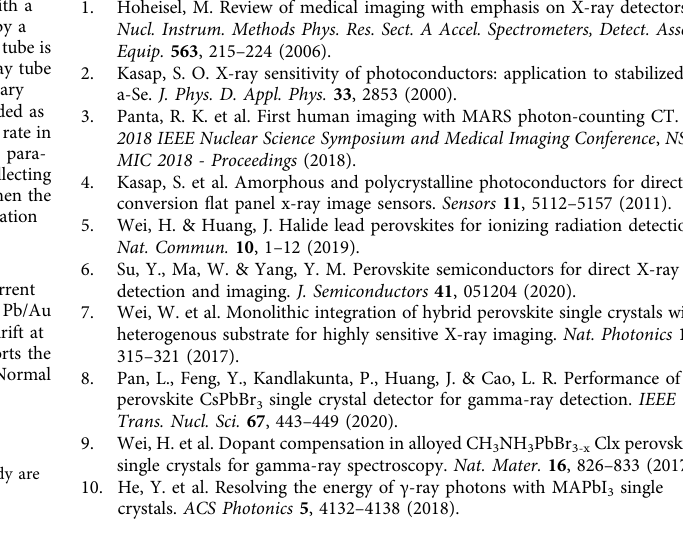
I X – ray and I dark ,